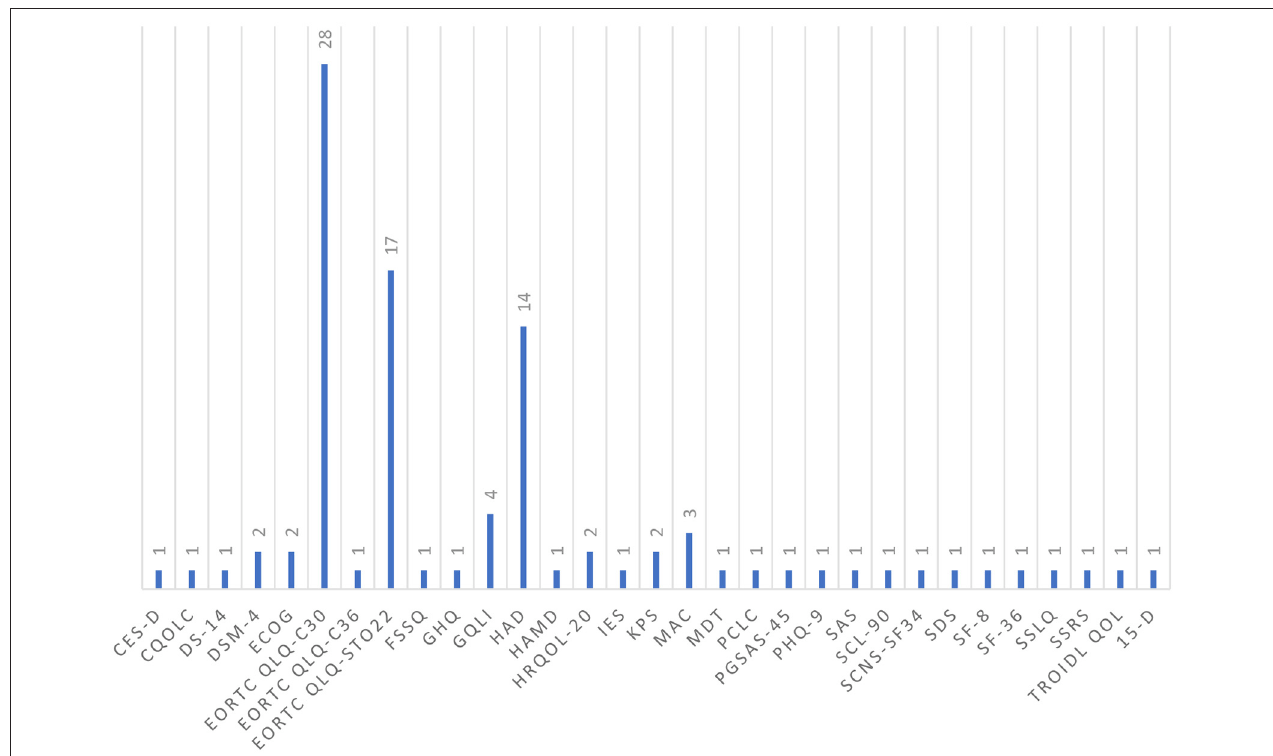
FIGURE 2 | Overview of different psychometric instruments used in the studies discussed (in alphabetical order). CES-D, Center for epidemiologic studies depression scale; CQOLC- Caregiver quality of life index cancer scale; DS-14, the type D scale-14; DSM-4, Diagnostic and statistical manual of mental disorders- fourth edition; ECOG, Eastern cooperative oncology group score; EORTC-QLQ-C30, European organization for research and treatment of cancer quality of life core questionnaire; EORTC-QLQ-C36, European organization for research and treatment of cancer quality of life core questionnaire 36 items; EORTC- QLQ-STO22, European organization for research and treatment of cancer quality of life questionnaire-stomach; FSSQ, functional social support questionnaire; GHQ, general health questionnaire; GQLI, Gastric quality of life index; HAD, Hospital anxiety and depression scale; HAMD, Hamilton rating scale for depression; HRQOL-20, health- related quality of life questionnaire; IES, impact of events scale; KPS, score- Karnofsky performance status scale; MAC- Mental adjustment to cancer scale; MDT, modified distress thermometer; PCLC, posttraumatic stress disorder and depression checklist, Civilian Version; PGSAS-45-Postgastrectomy syndrome assessment scale; PHQ-9, Patient health questionnaire; SAS, Cantril’s self-anchoring scale; SCL-90, symptom checklist-90; SCNS-SF 34, Supportive care needs survey; SDS, Sheehan disability scale; SF-8, Short-form health survey; SF-36- 36-item short form health survey; SSLQ, self- rating scale of life quality; SSRS, Suicide severity rating scale; Troidl QOL, Troidl quality of life index; 15D- quality of life questionnaire- 15